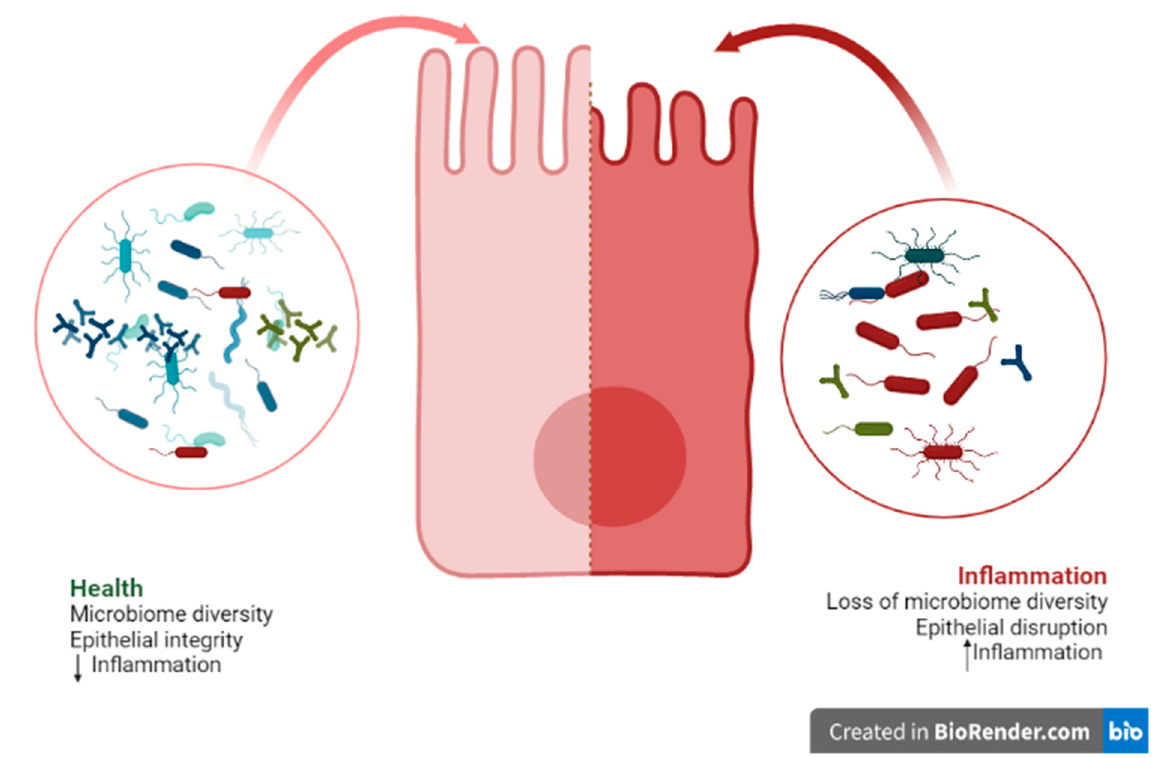
Figure 1. Representative figure of an epithelial cell and its interactions with the microbiome.